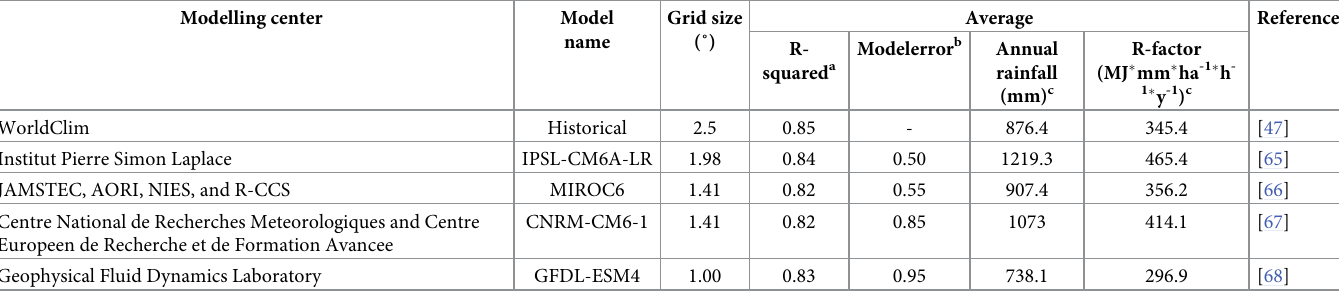
a Averaged for all downscaled climatic scenarios except for the historical scenario b Averaged from four error coefficients (0–2), which represent the classification performance achieved by four atmospheric circulation systems described by